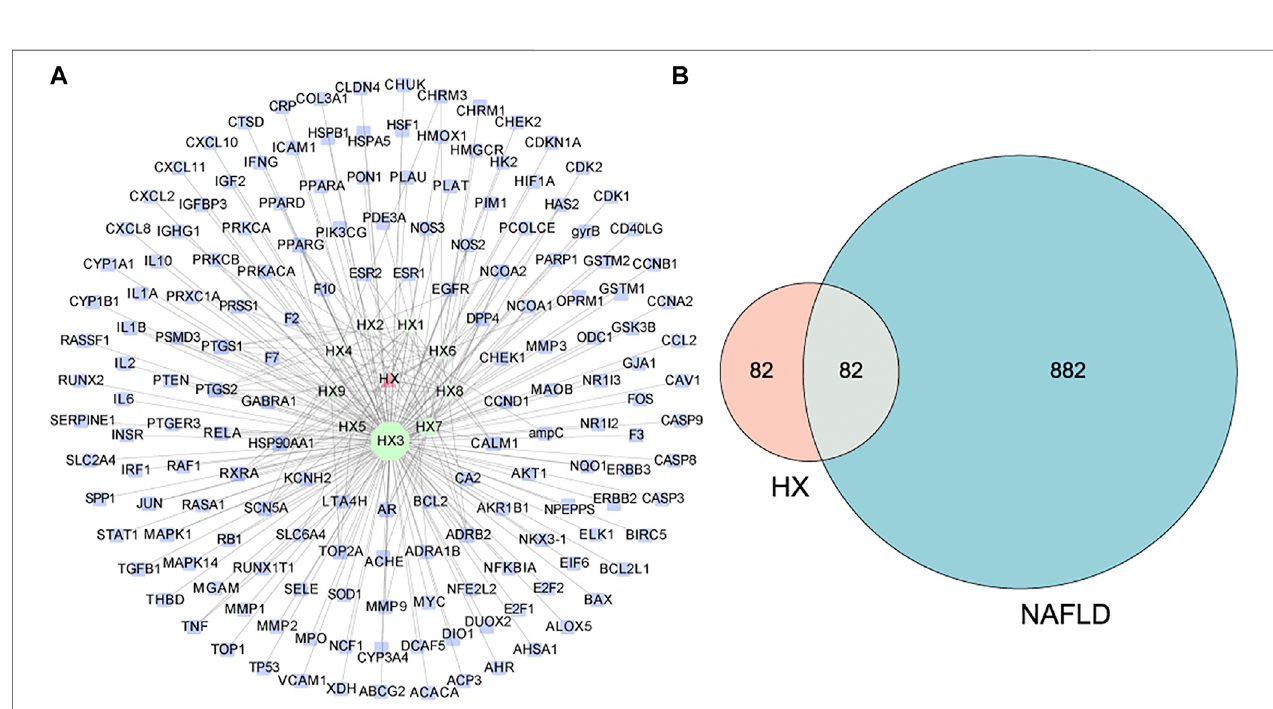
FIGURE 2 | Predicted effects of HX against NAFLD. (A) The compound target network of HX, which consists of 164 compound target nodes, 174 compound nodes, and239edges.Thehexagonsingreenrepresentcompounds,whilethesquaresinbluedenotepotentialtargets. Thenodesizeofgenetargetsisproportionalto the number of degrees. Lines represent the relationship between compounds and target nodes. (B) Venn diagram of active ingredient targets and disease proteins.